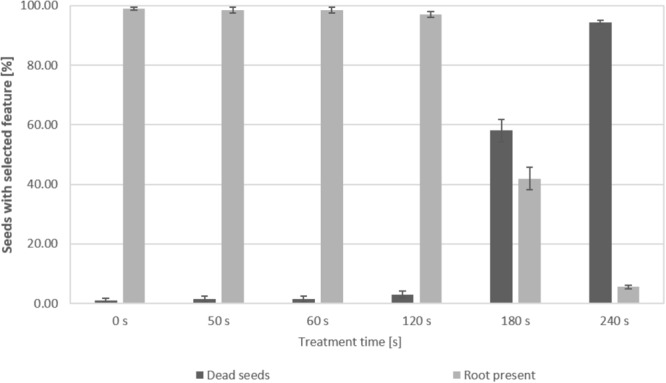
Quantitative assessment of the germination capacity of lentil seedlings after CAPP treatment in the DCSBD. The percentage of dead seeds or germinated seeds, showing the presence of a root, was determined for untreated seeds (0 s) and seeds after increasing plasma exposure times. Error bars express the standard deviation of triplicates for each data point in a 66 seed sample.